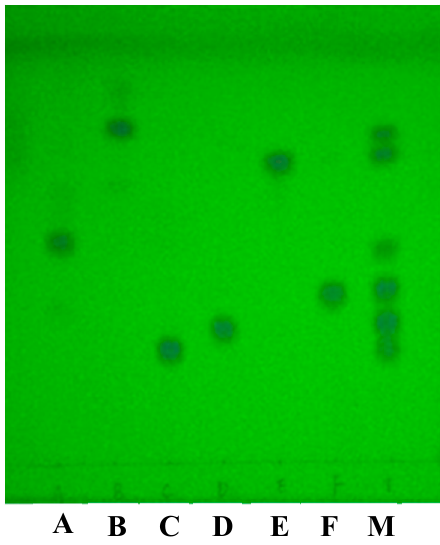
Figure 1. Results from TLC analysis of the six reference chemicals and mixture solution. A, B, C, D, E, F: reference substance of prednisone, prednisone acetate, prednisolone, hydrocortisone, hydrocortisone acetate, and dexamethasone; and M: mixture solution.